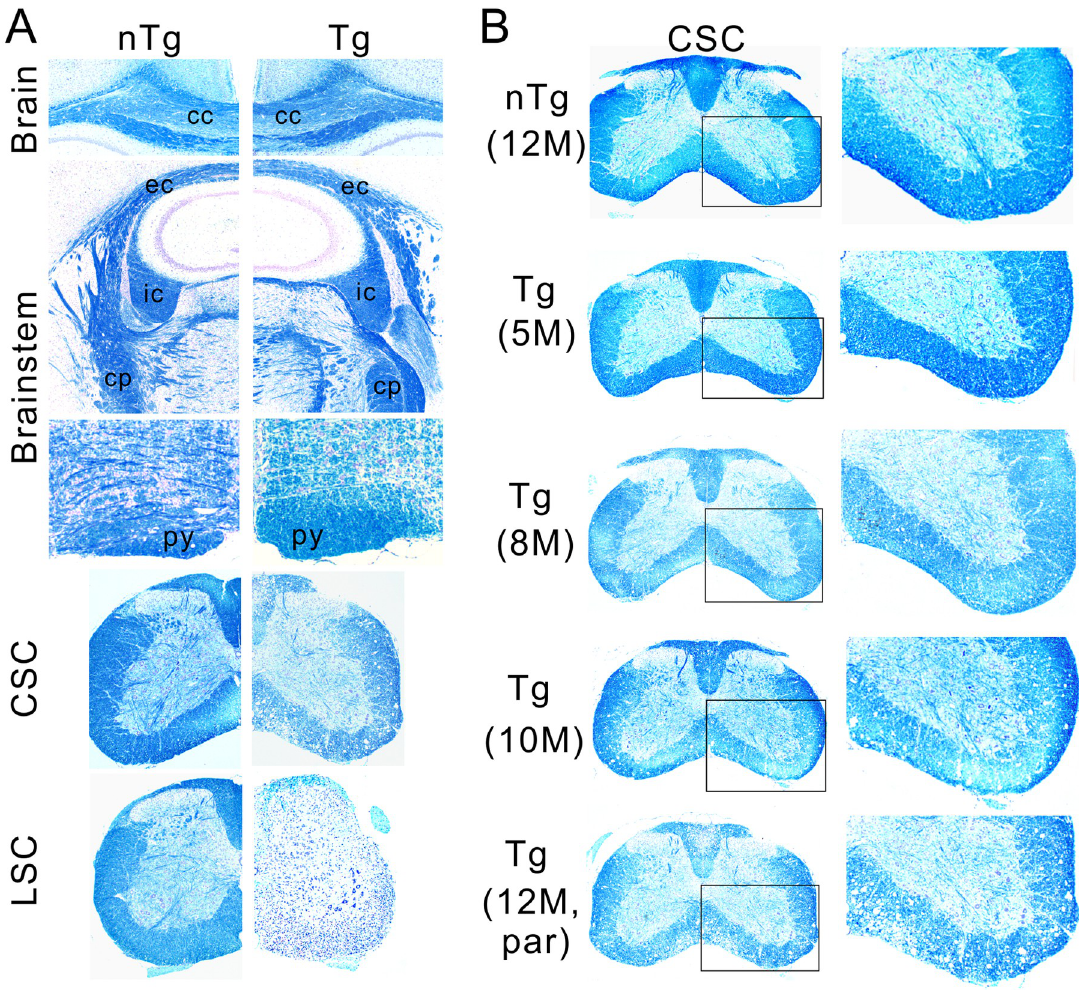
Fig 11. A survey of demyelination in the CNS. (A) The severity of myelin degeneration showed a caudal to rostral gradient in the CNS, with the lumbar spinal cord (LSC) being the most severely affected, followed by the cervical spinal cord (CSC), lower brainstem, upper brainstem, and corpus callosum (cc). py = pyramidal track, cp = cerebellar peduncle, ic = internal capsule and ec = external capsule. (B) The progression of demyelination in the cervical spinal cord. The panels on the right are enlargements of boxed areas in the panels on the left. Notice the degree of demyelination is less severe than in the lumbar spinal cord at 12 months old (compare with Fig 5A and also between LSC and CSC in A of this figure). Shown are images representative of five or more animals for each genotype and at each age